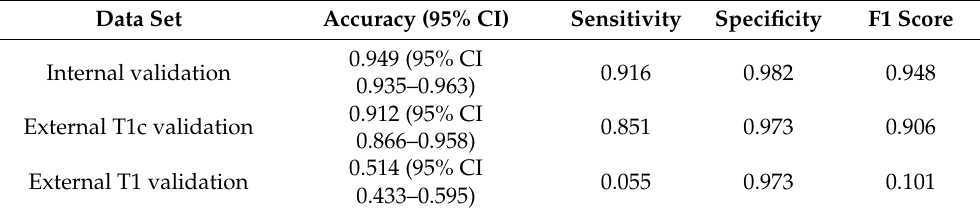
Figure 3. Flattened cross-entropy loss of the training (blue) and internal validation (orange) data set across the 15 unfrozen epochs. Table 2. Performance metrics of the internal, external T1c, and external T1 validation cohort. 95% CI: 95% confidence